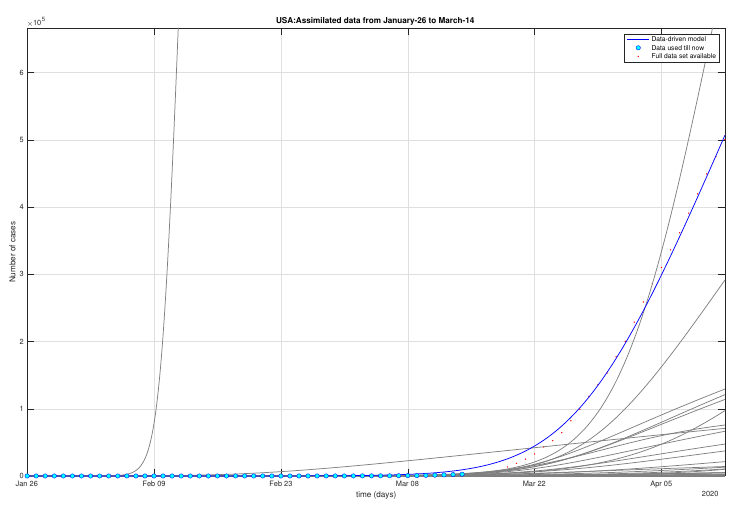
Figure 18. Brazil: Sequential data-driven model.